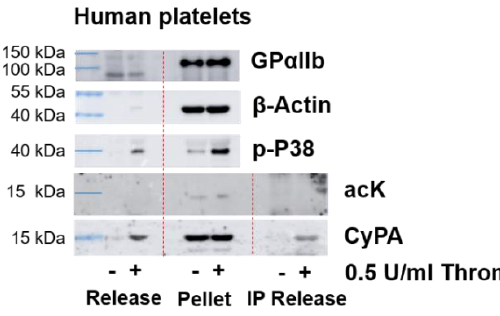
Figure 4. Western blot analysis of released Cyclophilin A in platelets. Platelets were stimulated with thrombin for 5 min. Release of CyPA from activated platelets was analyzed by Western blot, demon-